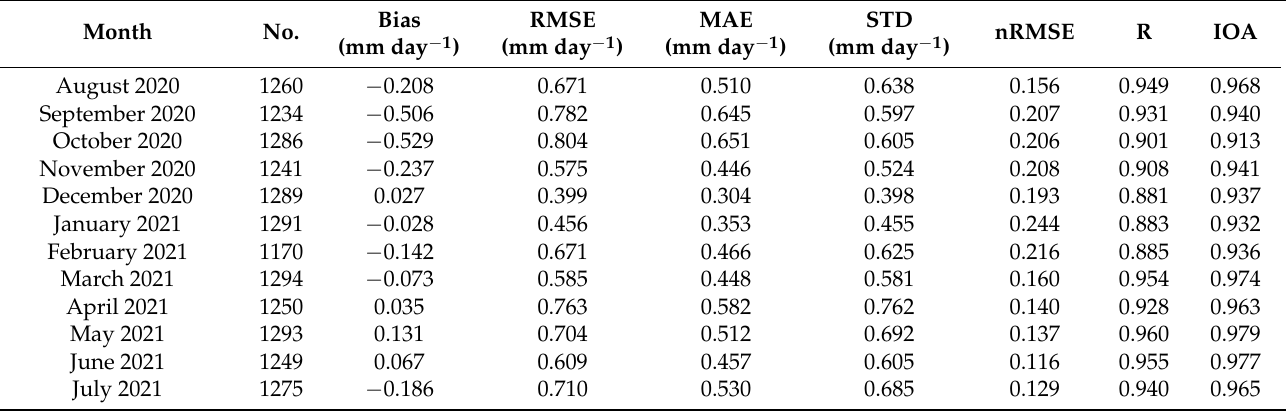
Table 5. Accuracy (in terms of bias, RMSE, MAE, STD, nRMSE, R , and IOA), of the GK2A/AMI satellite-derived estimated PET, with respect to the